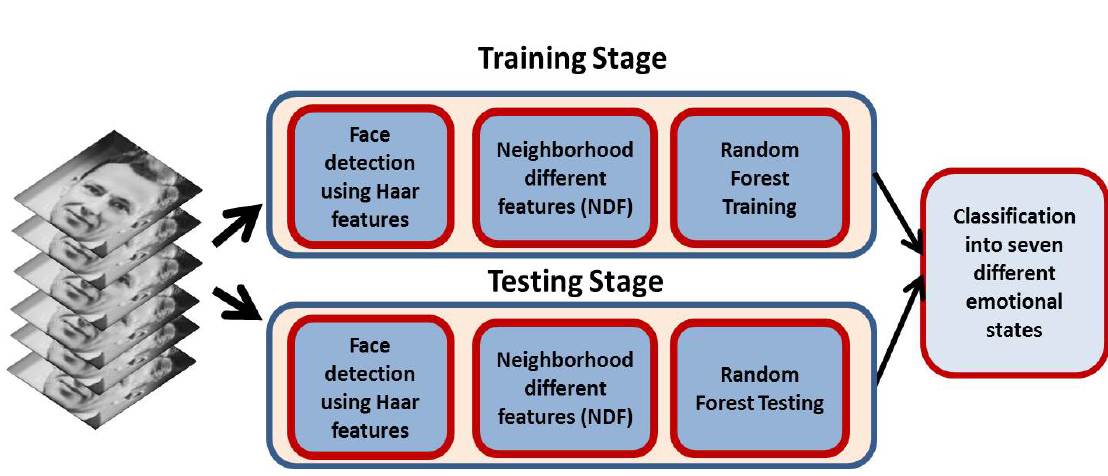
Figure 1. Emotions’ classification. The proposed method detects faces in the input frames/images and then extracts neighboring difference features (NDF) from the detected faces. These features are used to train a random forest classifier during the training stage. The same features are used to classify facial emotions into seven different states during the testing